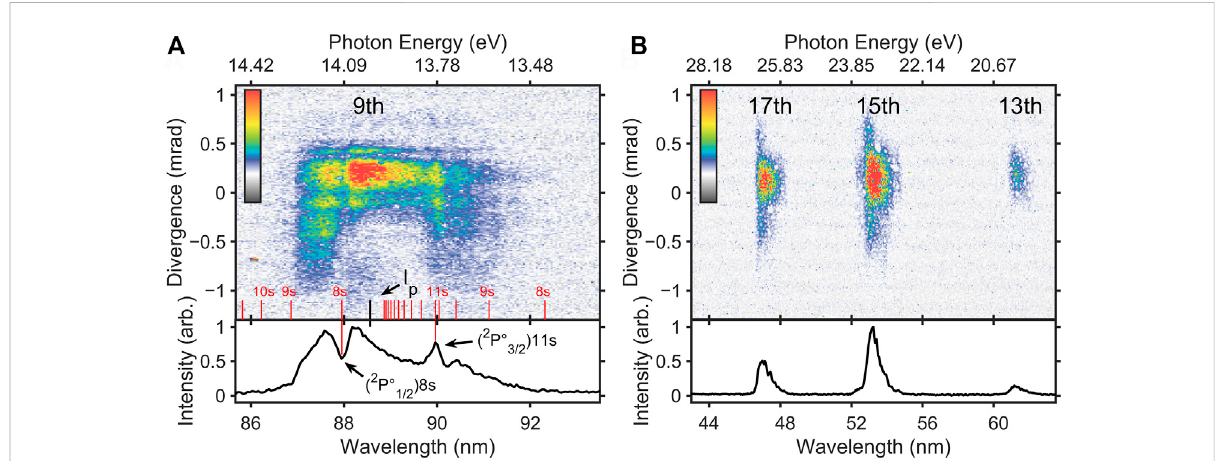
FIGURE 1 Comparison of the 9th-harmonic (A) and higher order harmonic (13th, 15th, and 17th) (B) spectra from krypton. The upper fi gures show the harmonic spectra measured by the CCD. The horizontal axis represents the photon energy, and the vertical axis is the divergence of the harmonic, whichiscalculatedaccordingtothedistancefromthegascelltotheCCD.Theredlinemarksthecoherencelineemissions(4 p 6 → 4 p 5 ns )neartheKr ionization energy. The fi gures below represent the vertical integration of the upper fi gures, and the horizontal axis is converted to the corresponding wavelength. The indium foil fi lter was replaced with aluminum foil with the same thickness when acquiring 13th, 15th, and 17th spectra because of low-transmittance.